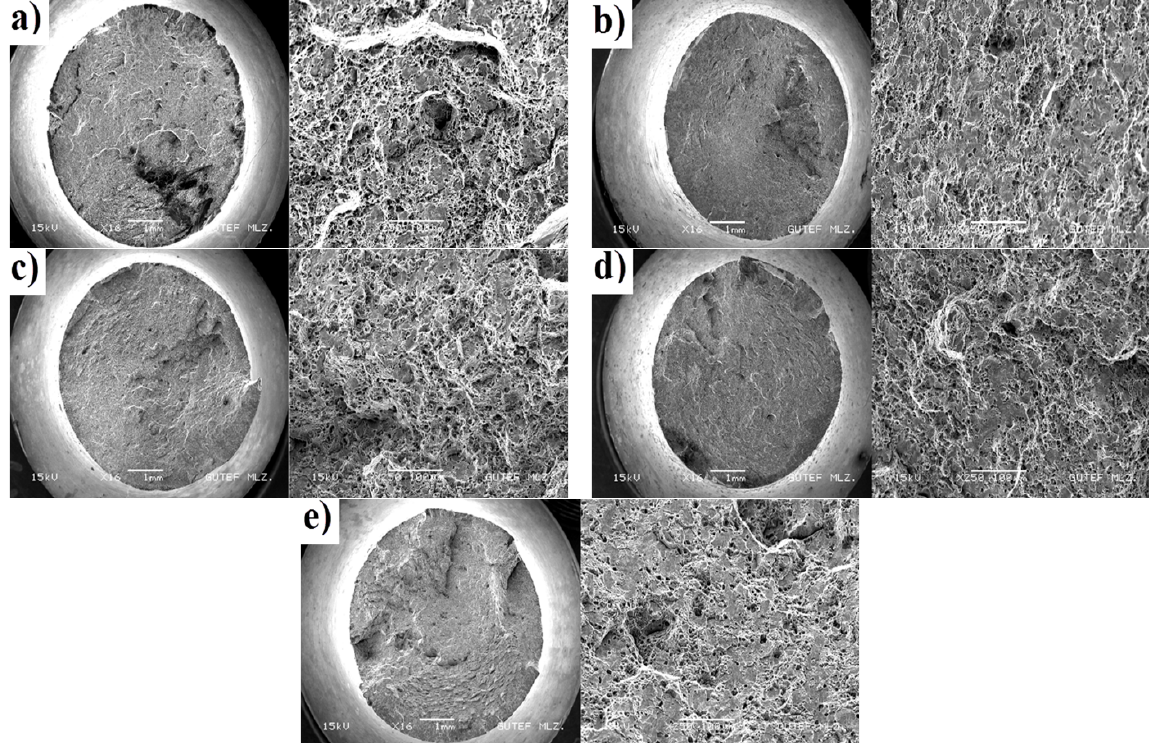
Figure 4: The fractured surface SEM images of the alloys after the tensile tests a) 465 ∘ C b) 470 ∘ C c) 475 ∘ C d) 482 ∘ C e) 485 ∘ C.